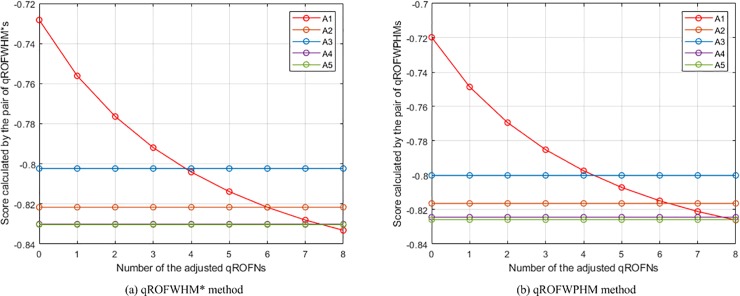
The changes of the places of A1 in the rankings of the WHM* and WPHM methods.